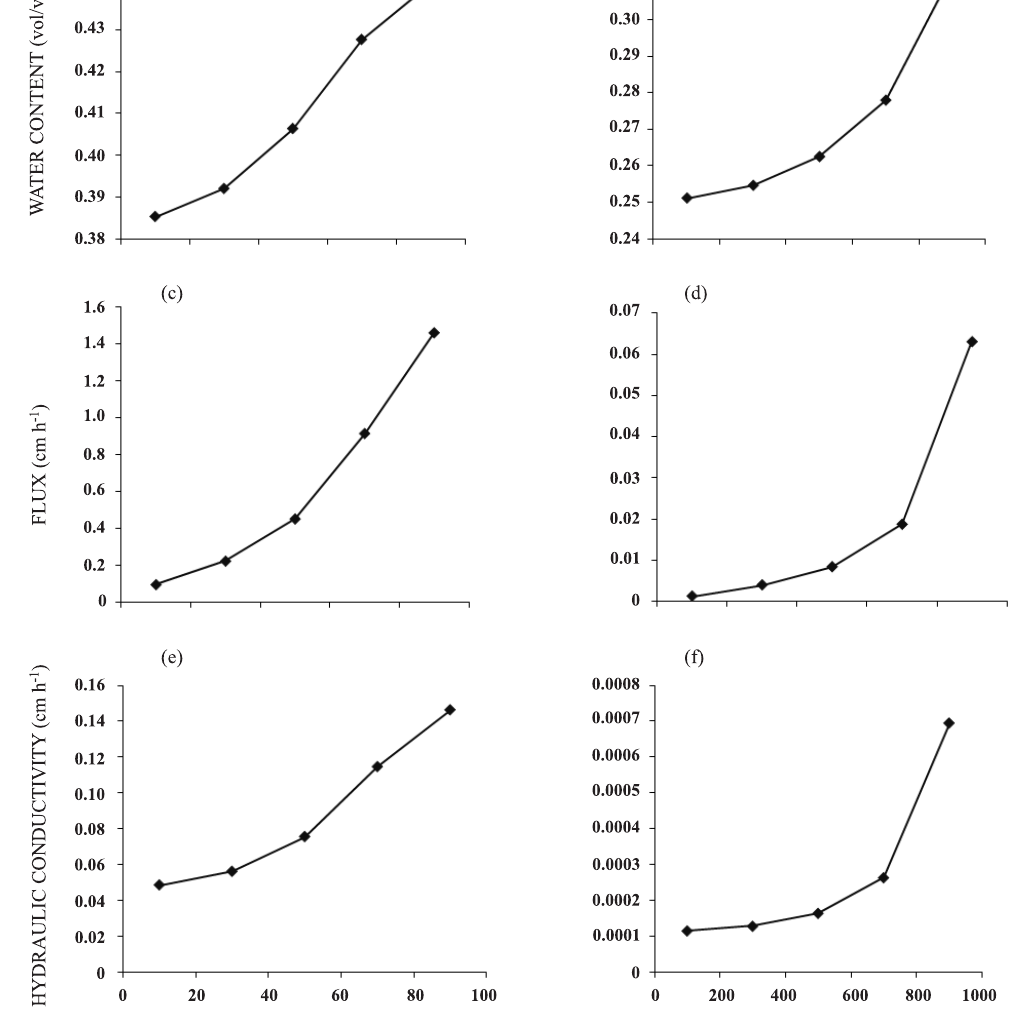
Figure 5. Water content (a and b), hydraulic flux (c and d) and hydraulic conductivity (e and f) vs. head difference (upper BC – lower BC) in the layered